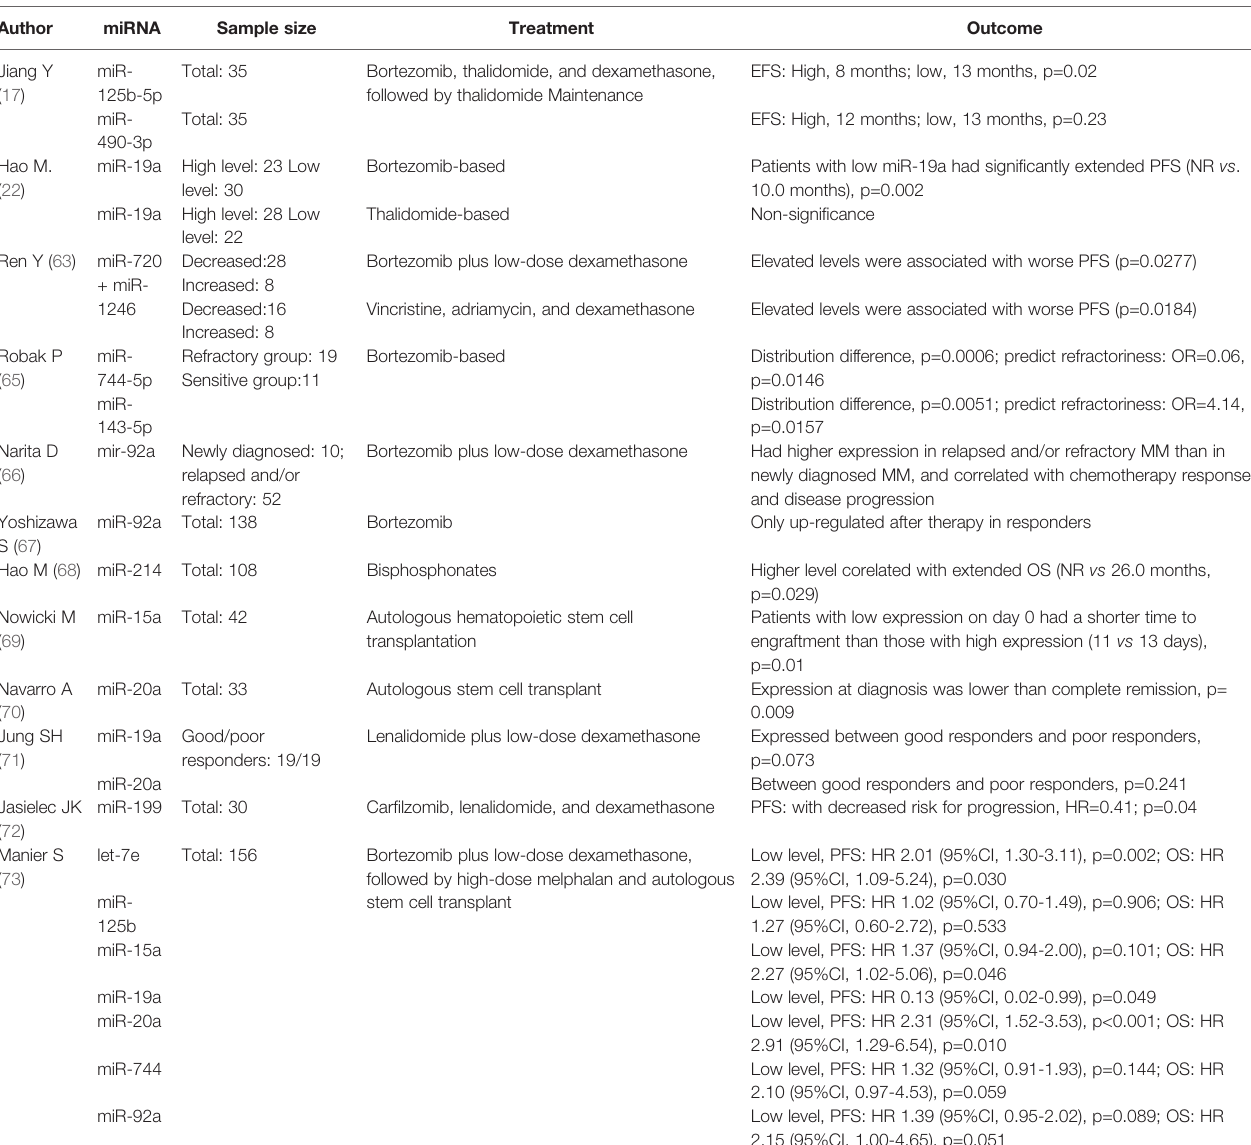
TABLE 8 | Application of circulating miRNAs in speci fi c treatment of multiple myeloma. miRNA Sample size Treatment